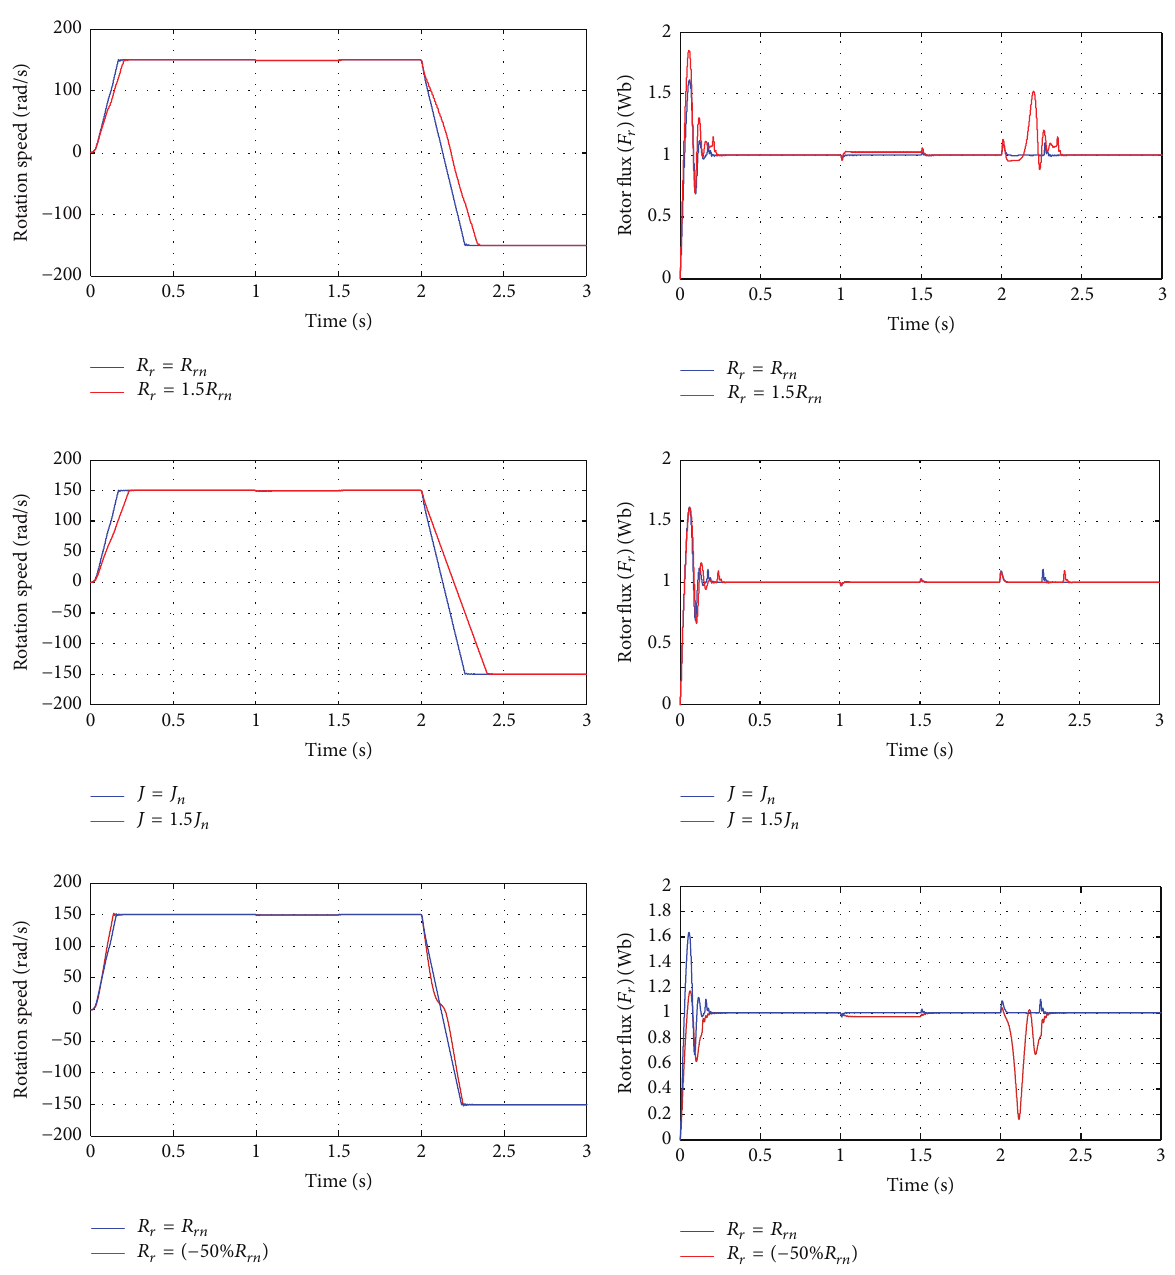
Figure 9: Control by fuzzy controller (PI) with varying